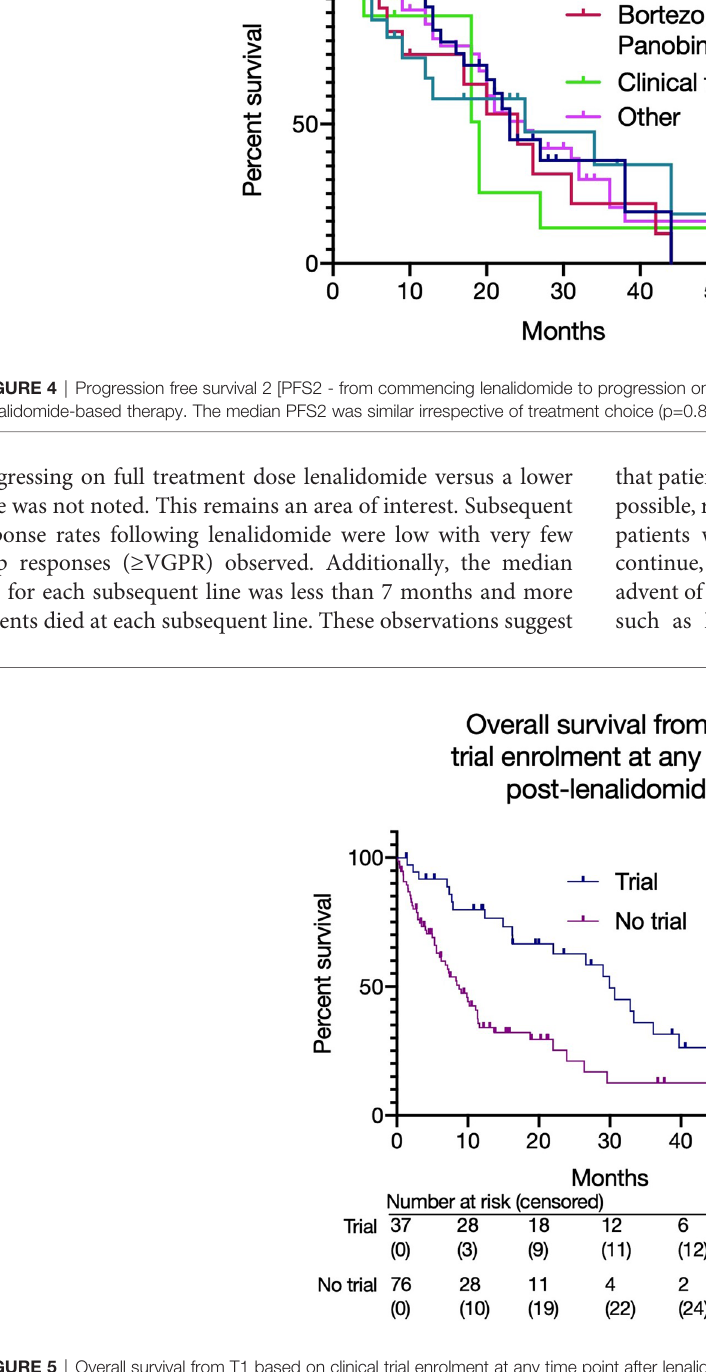
FIGURE 5 | Overall survival from T1 based on clinical trial enrolment at any time point after lenalidomide-based treatment.